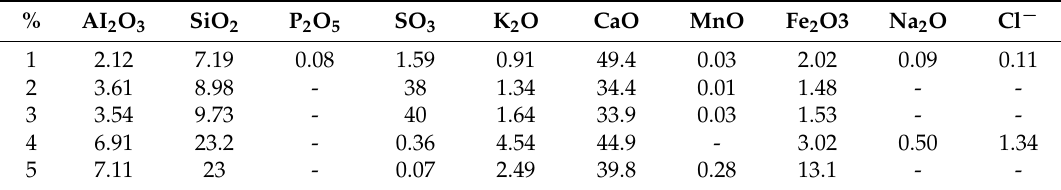
Table 1. Chemical analysis by XRF (%) of five historical mortars.